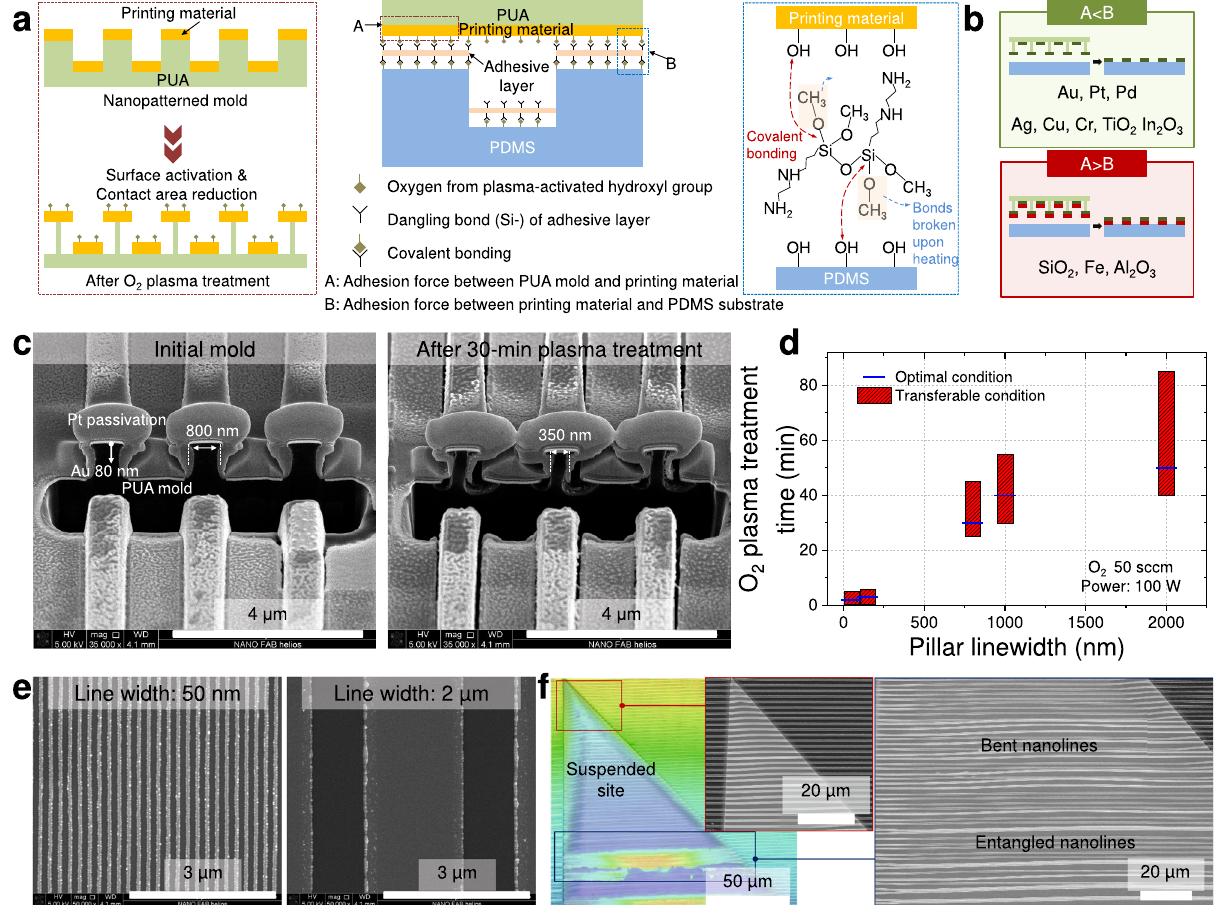
Fig. 2 | Mechanism and fabrication details of two-dimensional nanotransfer printing on the elastomer substrate. a Schematic mechanism of nanotransfer. The area enclosedby a red dotted line shows the effectofO 2 plasmatreatment on themoldwiththetargetmaterial,andtheareaenclosedbyabluedottedlineshows the chemical reactions of the adhesion promoter during nanotransfer printing. b Schematic effects of material properties on material transferability during nanotransfer printing. Materials with weak intrinsic adhesion to the mold can be transferred directly (area enclosed by the green line), while those with strong intrinsicadhesionrequireasupportinglayer(e.g.,Au)fortransfer(areaenclosedby theredline). c Side-viewscanningelectronmicroscopyimagesofthemoldwiththe target material before and after 30-min treatment with O 2 plasma. d Effects of